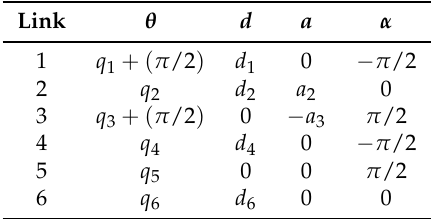
Figure 3. Coordinate systems for all the links of the PUMA 560 robotic arm. Table 1. Denavit–Hatenberg Parameters of PUMA 560.